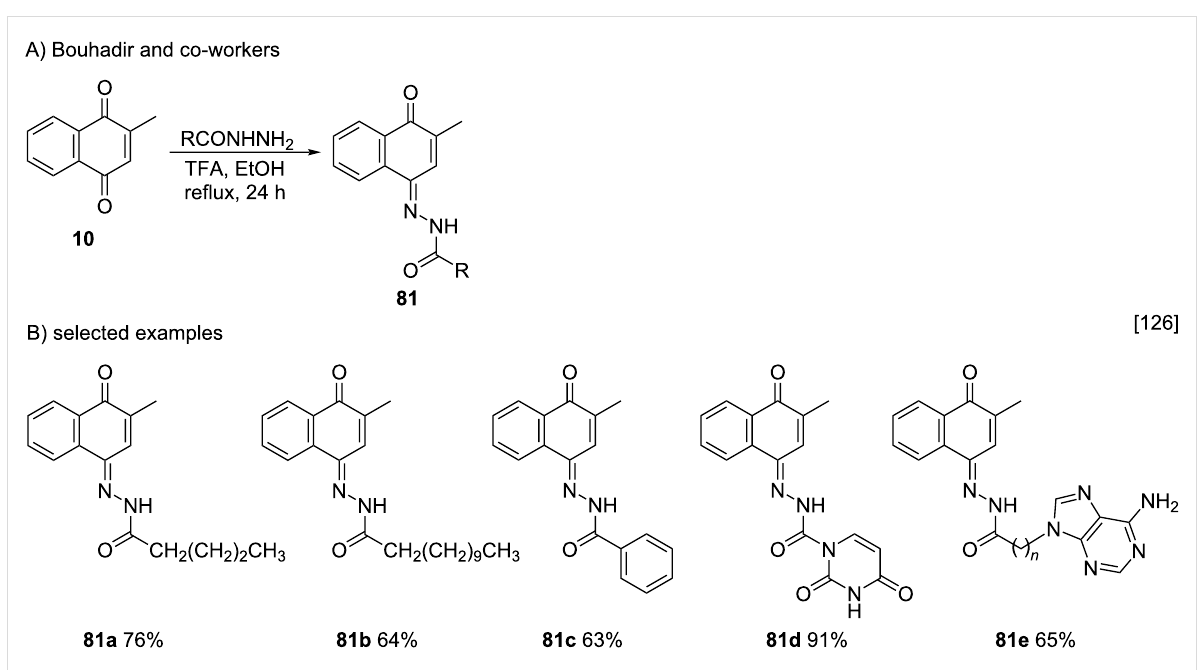
Scheme 26: Condensation reaction of menadione with acylhydrazides.